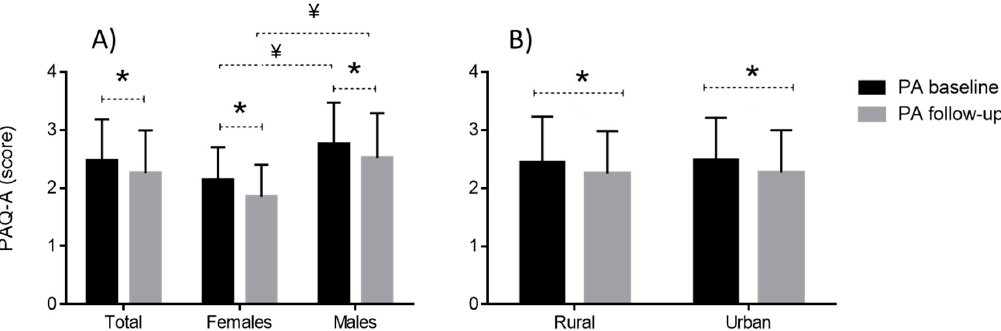
Figure 2. Descriptive statistics (presented as Means+Standard Deviations) for the physical activity level as measured by Physical Activity Questionnaire for Adolescents (PAQ-A) at baseline and follow–up, with differences between groups and within groups (* indicates significant [ p < 0.01] within–group differences obtained by t-test for dependent sample; ¥ indicates significant [ p < 0.01] between group differences obtained by t-test for independent samples).